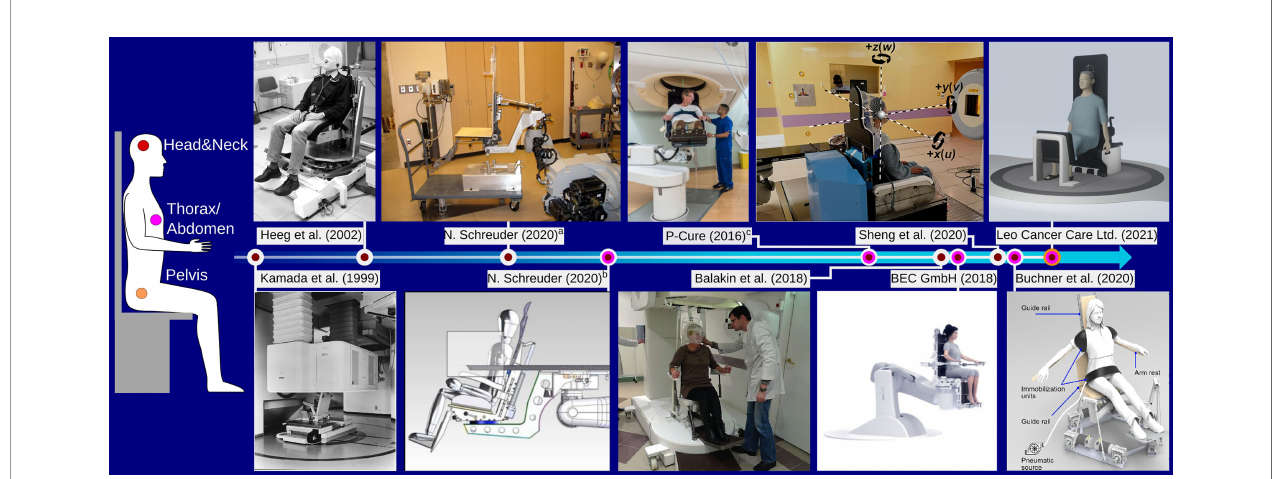
FIGURE 1 | Overview over different chair designs targeted for particle therapy found in literature, focusing on those that were constructed as prototype. The color of the time line connectors indicates the chair ’ s intended use with respect to different treatment sites, as shown on the left. a The chair was installed at the Indiana University Health Proton Therapy Center prior to 2006, as described by Schreuder (30). b The device was installed at the Oklahoma Proton Center as described in (30). The fi gure shows the couch overlayed on the chair. c The chair system is installed at Northwestern Medicine Chicago Proton Center and was designed by P-Cure 1 . Image reprinted with kind permission by Dr. M. Pankuch (Northwestern Medicine Chicago Proton Center). Images a , b , and the Leo Cancer Care Ltd (2021). were reprinted with kind permission by Dr. N. Schreuder (Leo Cancer Care Ltd.). Kamada et al. (1999): Reprinted from Kamada et al. (5) with permission from Elsevier. Buchner et al.